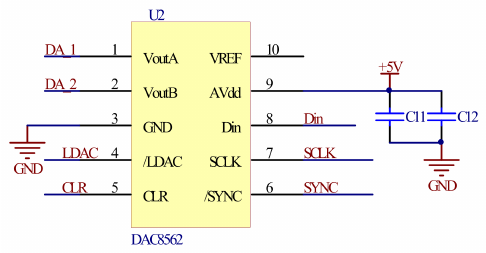
Figure 6. D/A converter circuit.